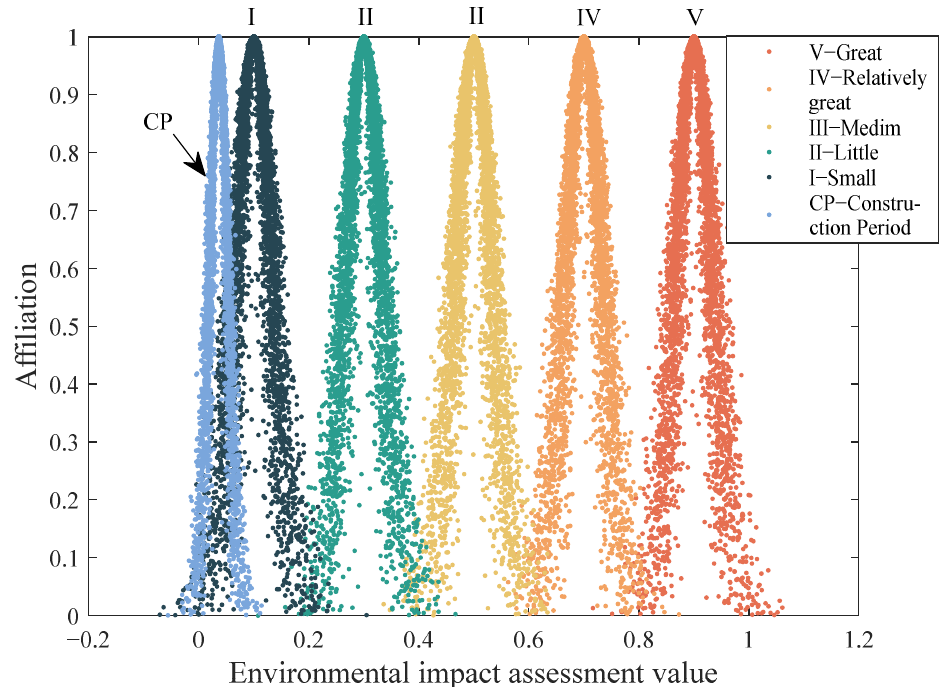
Figure 3. Cloud map for a comprehensive evaluation in the construction period. According to the calculation results of the standard cloud parameters and the cloud model parameters of each index in Table 2, the greater the expected value in the standard cloud model, the greater the impact. The expected values of P1 and P2 are the largest when the tunneling parameters are not adjusted in time. The expected values of the I2 and R1 indicators are slightly smaller than those of P1 and P2, which indicates that the negative indexes P1 and P2 have a greater negative impact on the environment in the construction process. Pollution and damage to the original environment in the construction period re- quire attention, but in general, the impact on the environment in the construction period is positive and small.